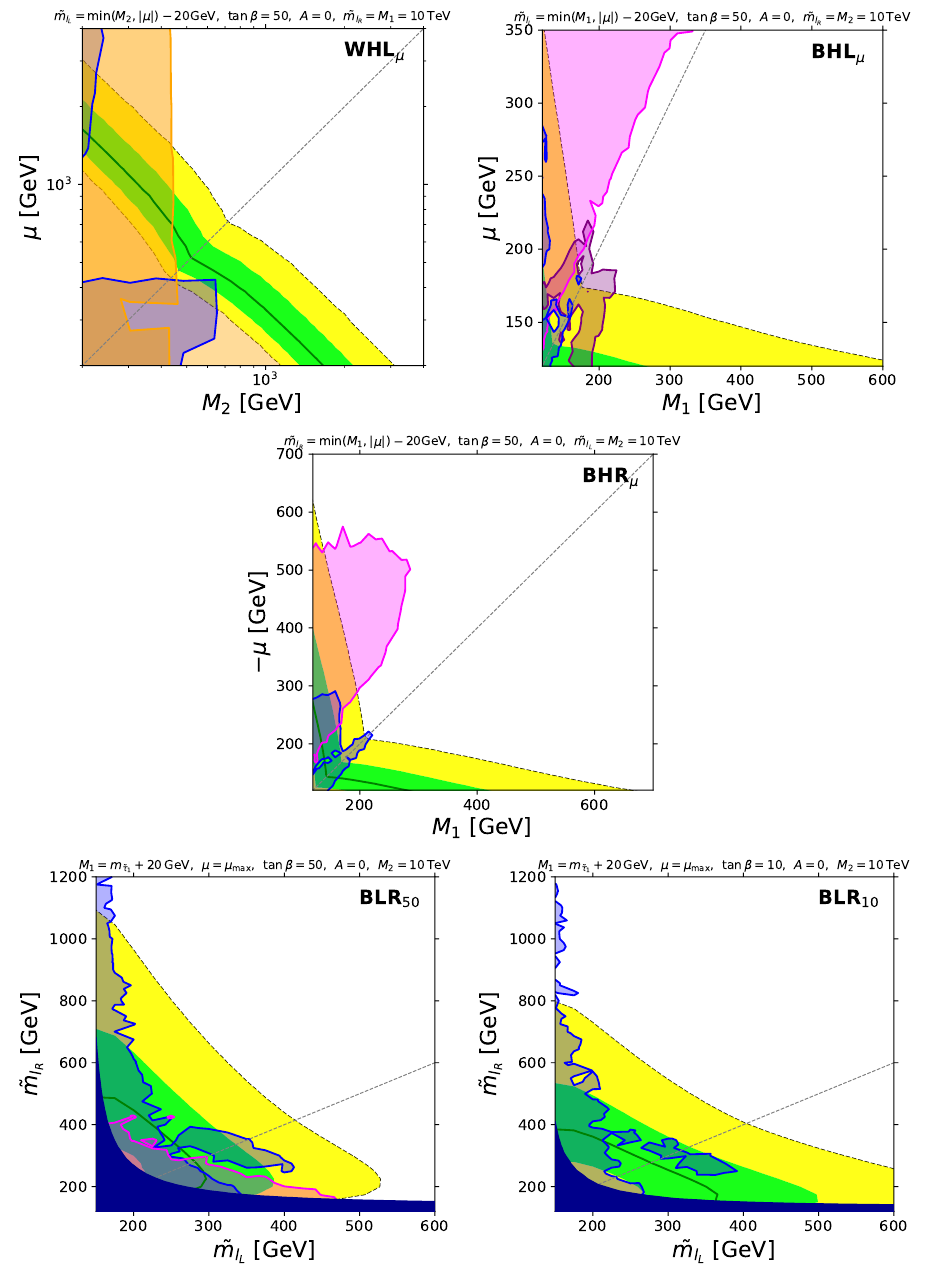
Figure 8 . Results for GMSB with NLSP different from neutralino: WHL µ (upper left), BHL µ (upper right), BHR (middle), BLR (lower left) and BLR (lower right) planes. Region of µ 50 10 parameter space allowed by the latest a experimental results [4] is depicted with green and yellow µ bands, corresponding to one and two sigma agreement respectively. Blue, orange, purple and magenta shaded regions are excluded by LHC constraints. Dark blue shaded area is excluded by LEP stau mass bound